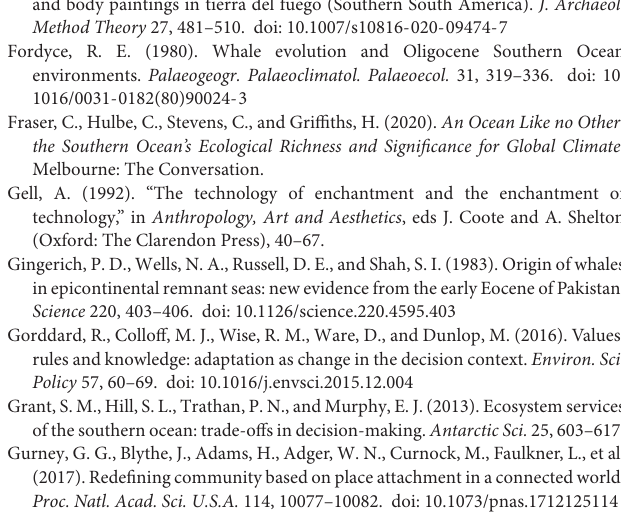
did the Figure 1 /Graphical abstract artwork. JM-T, LR, and KP did Figure 2 . Interactive map with stories: